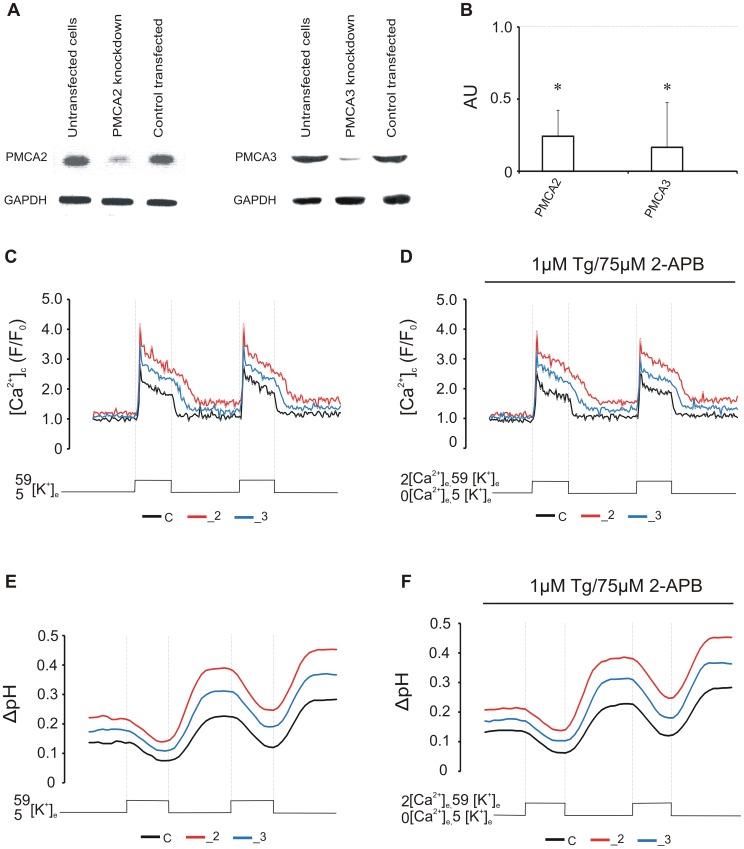
Changes in (Ca2+)c and ΔpH are reproduced in transiently transfected cells.(A) Immunodetection of PMCA2 or PMCA3 in PC12 cells transiently transfected with phosphothioate oligodeoxynucleotide probes. (B) Densitometric analysis of PMCAs showing ∼75% knock-down of target genes. The results are presented as arbitrary units (AU) obtained after normalization to endogenous GAPDH level. The dotted line shows the value for untransfected cells (control cells). * P<0.05 PMCA-downregulated cells vs. control cells. (C) The effect of transient PMCAs silencing on (Ca2+)c in n = 17 cells for each line without or (D) with the presence of thapsigargin and 2-APB in n = 20 cells for each line. (E) corresponding changes in ΔpH without or (F) with the presence of thapsigargin and 2-APB.